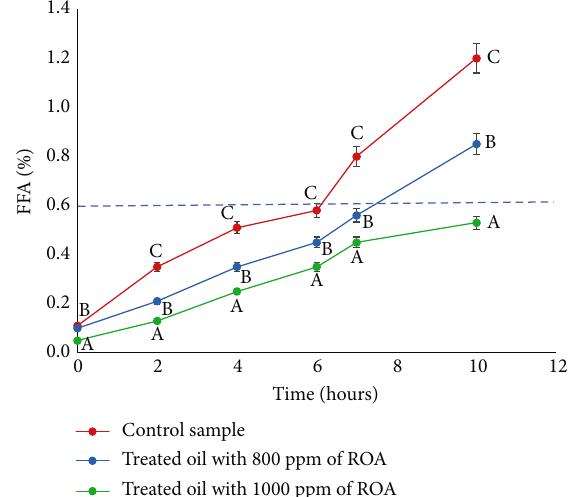
Figure 3: Development of free fatty acids during the frying of breaded shrimp in soybean oil. The values followed by di ff erent letters (A, B, and C) are signi fi cantly di ff erent from each other at p < 0 : 05